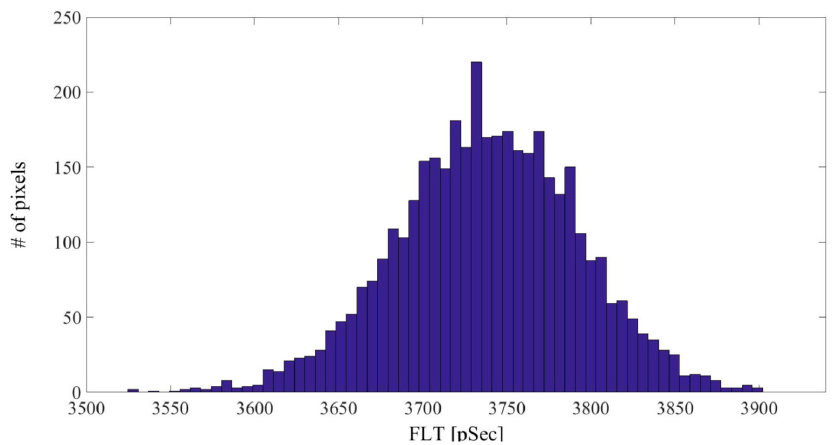
Figure 4. FLT histogram of free fluorescein phantom. The fluorescein concentration in the phantom was 0.33 µM. Table 2. This table summarizes the results of τ 1 , a 1 % (the percentage of τ 1 of the pixel’s FLT), χ 2 (the